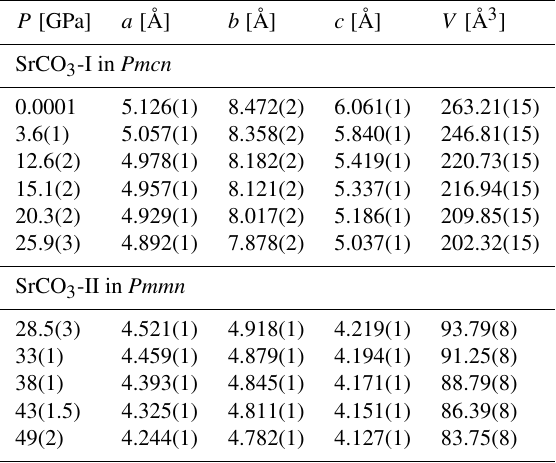
Table 2. Pressure dependence of lattice parameters of SrCO 3 at room temperature derived from powder X-ray diffraction.